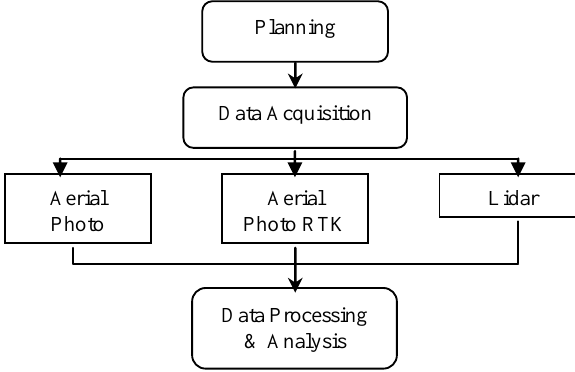
triangle) in the study